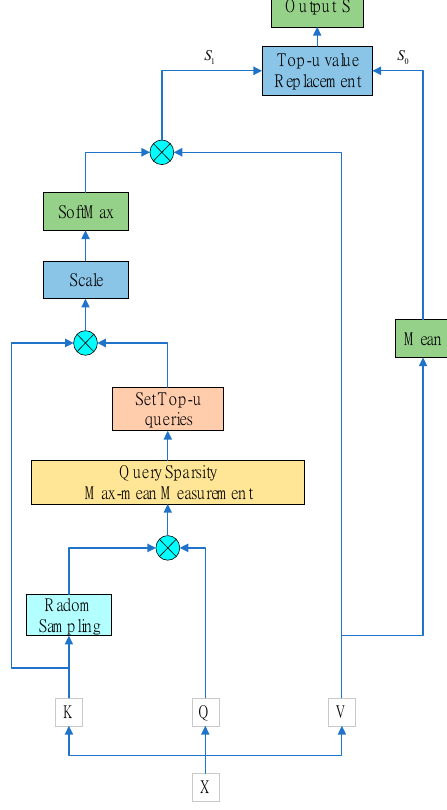
Figure 2. The prob-sparse self-attention architecture. According to Zhou et al., scaled dot-product attention has a long tail distribution at its output, meaning that only a small subset of dot products warrants any real consideration. The dissimilarity between the two distributions can be evaluated with the help of Kullback–Leibler divergence [33], and the main dot-product pairs can be screened out, with the evaluation of the i th query sparsity being obtained as follows: